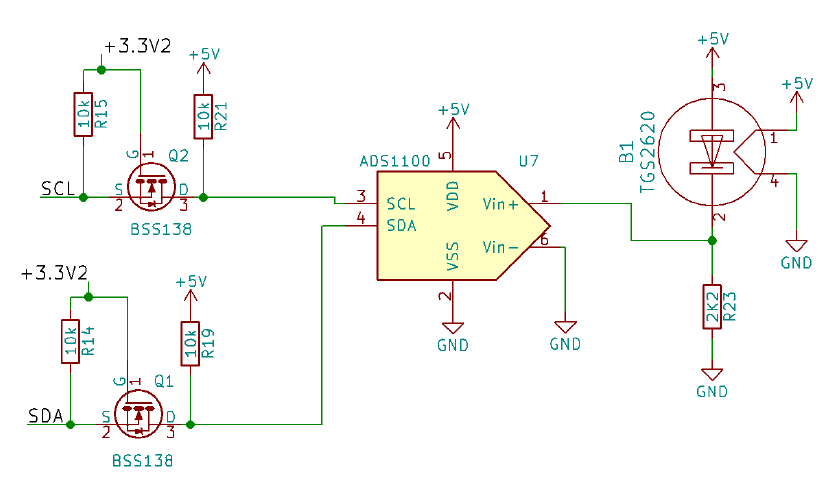
Figure 7. Schematic showing the TGS2620 sensor and the external ADC converter.